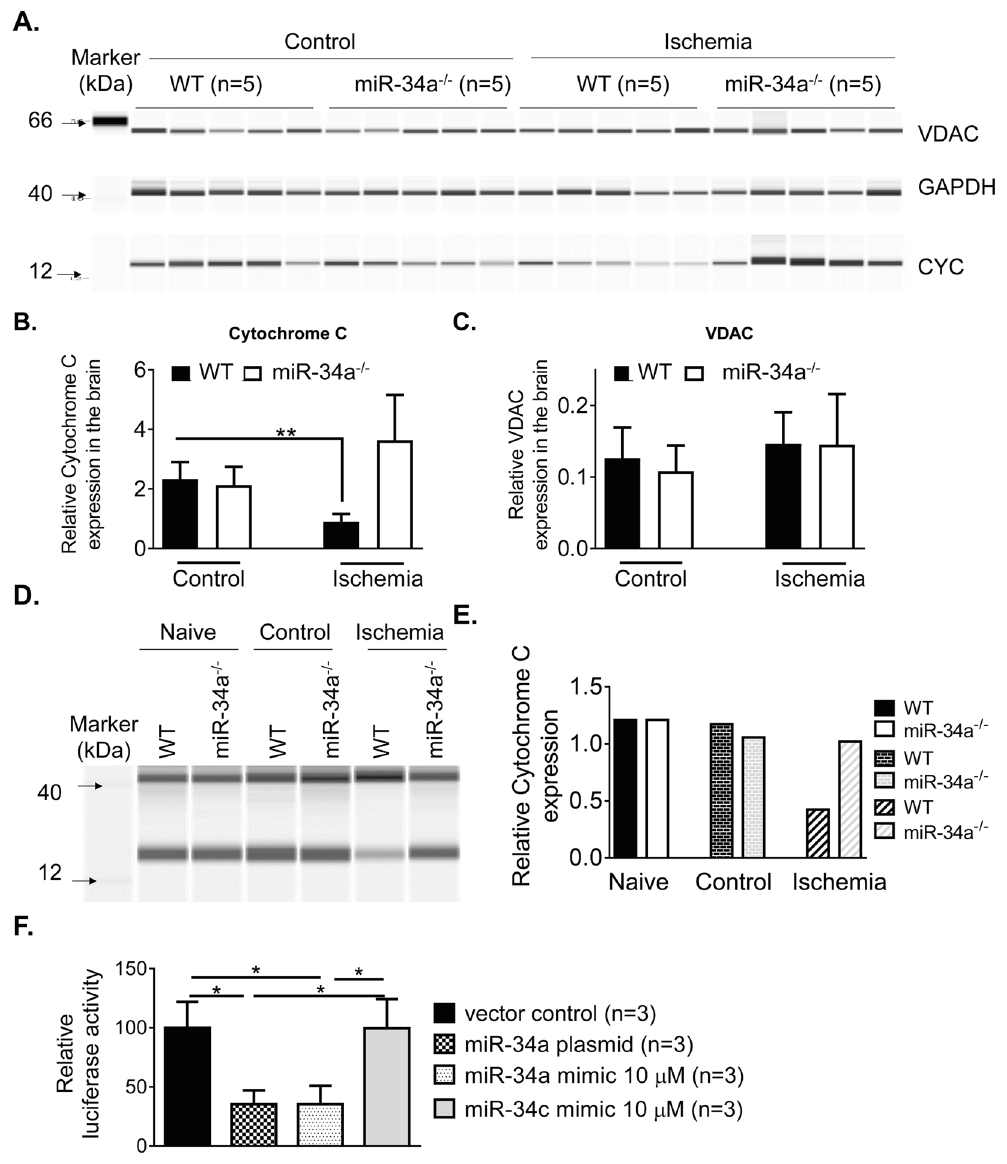
Figure 4. MiR-34a affects stroke outcomes via interacting with cytochrome c. ( A ) WES system image showing CYC, VDAC and GAPDH expression from hemispheres of WT and miR-34a − / − mice at 6 h post-stroke. (B) Relative CYC expression normalized to GAPDH from the data generated by the WES system. CYC level is significantly decreased in ischemic hemispheres of WT mice but no significant changes in miR-34a − / − mice between contralateral hemispheres (Control) and ischemic hemispheres (Ischemia). N = 5 per group, ** p < 0.01, One-way ANOVA followed by post hoc Tuckey’s test was used for data analysis. Data are expressed as mean ± S.D. (C) Relative VDAC expression normalized to GAPDH from the data generated by the WES system. VDAC was not significantly altered in WT mice nor miR-34a − / − mice. ( D ) Multiplexed WES system image showing CYC and GAPDH expression from purified pCECs of WT and miR-34a − / − mice (n = 10 per group, pooled cell samples) at 6 h post-stroke. ( E ) Relative CYC expression by normalization to GAPDH. A 2.8 fold decrease of CYC level was observed in WT mice but no changes were observed in miR-34a − / − mice between contralateral hemispheres and ischemic hemispheres. ( F ) A CYC reporter was coexpressed with a miR- 34a plasmid, a miR-34a mimic, a miR-34c mimic, or a plasmid control in cultured cerebral vascular endothelial cells for 24 hours. Relative firefly luciferase activity was evaluated and normalized to renilla luciferase activity. Relative firefly luciferase activity was reduced by miR-34a plasmid and miR-34a mimic. The experiment was repeated 3 times and triplicates were used for each analysis. Data represents the mean ± S.D. * p < 0.05. One- way ANOVA followed by post-hoc Tuckey’s test was used for